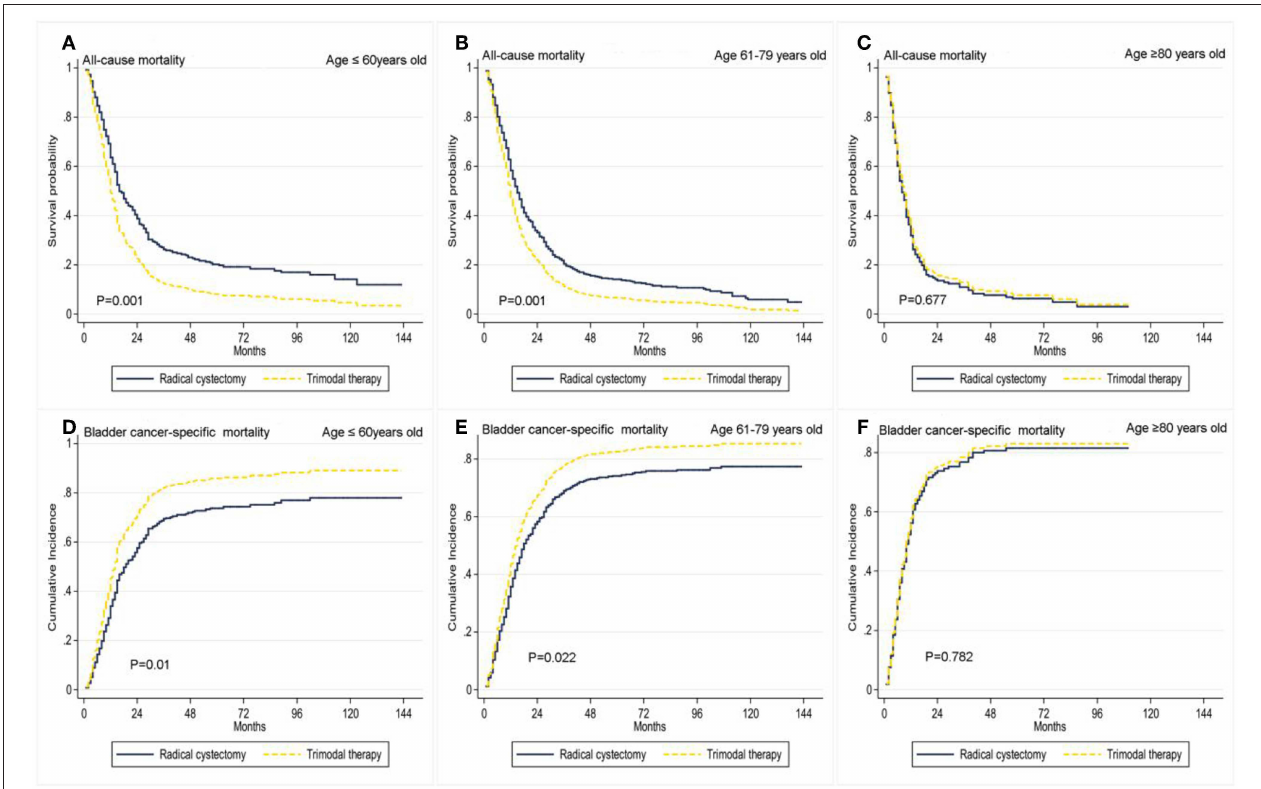
FIGURE 3 | Adjusted survival curves for all-cause mortality and bladder cancer-specific mortality by radical cystectomy ( A , age ≤ 60 years old; B , age 61–79 years old; C , age ≥ 80 years old) and trimodal therapy ( D , age ≤ 60 years old; E , age 61–79 years old; F , age ≥ 80 years old) after weighting in age